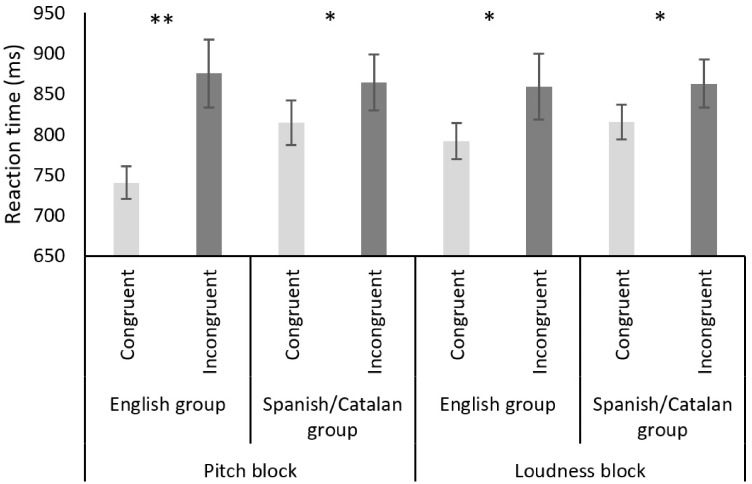
Mean RTs (in milliseconds) in each block (pitch/loudness) and group (English/Spanish–Catalan) for the two conditions (congruent/incongruent). Error bars indicate the standard error of the mean. Single and double asterisks indicate a significant difference between conditions (p < .05, and p < .01, respectively).